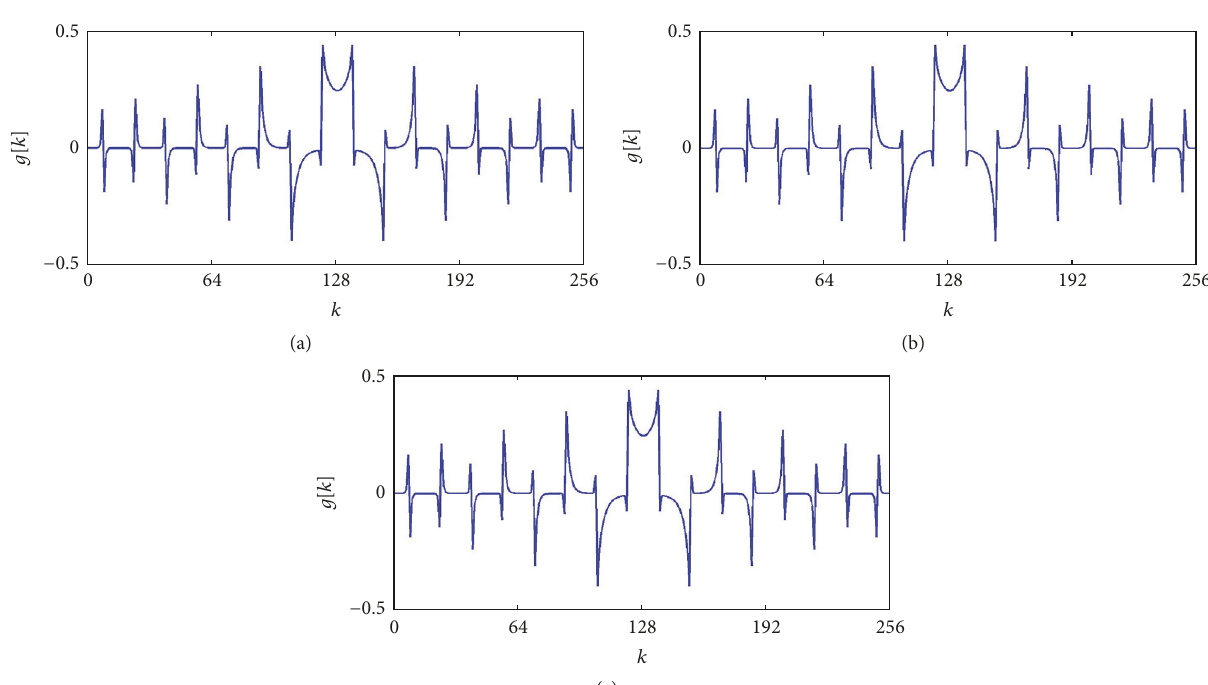
Figure 2: Analysis windows 𝑔[𝑘] in the critical case ( Δ𝑀 = 16 , Δ𝜔 = 16 , 𝛽 = 1 ) obtained by the proposed method [9,